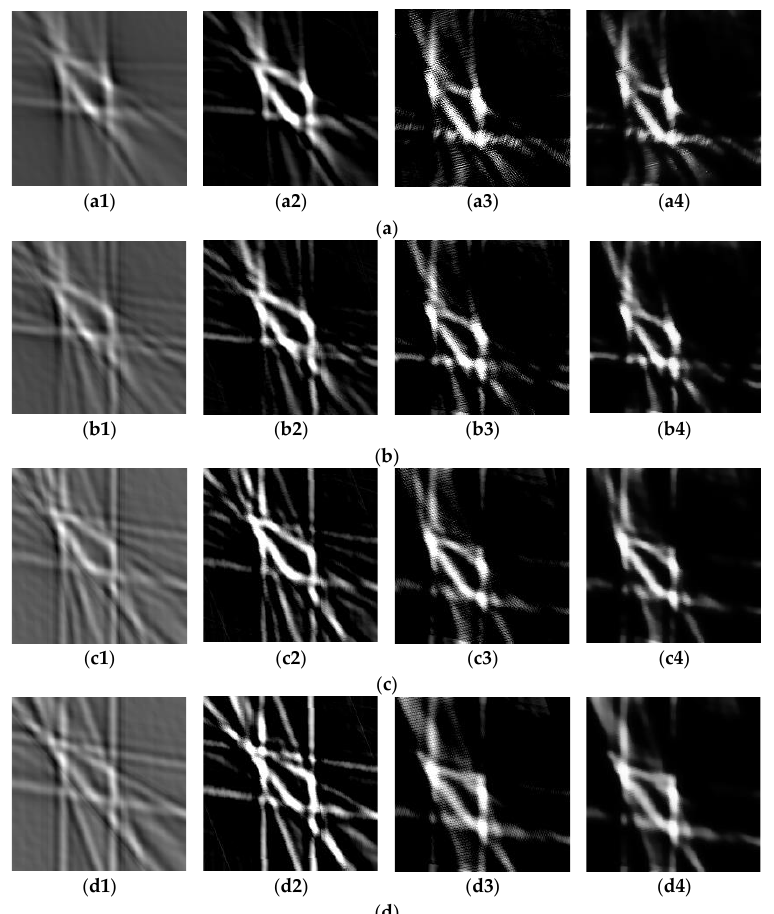
Figure 15. Far field experimental imaging results with uniformly sampled view of projections ( Far left ) iRadon; ( Left ) FBP; ( Right ) ART; ( Far right ) TV sparse reconstruction with ART. ( a ) Complete view data (a1:a4); ( b ) sampled data at 5° intervals (b1:b4); ( c ) sampled data at 10° intervals (c1:c4); ( d ) sampled data at 20° intervals (d1:d4). (c1:c4); ( d ) sampled data at 20 ◦ intervals